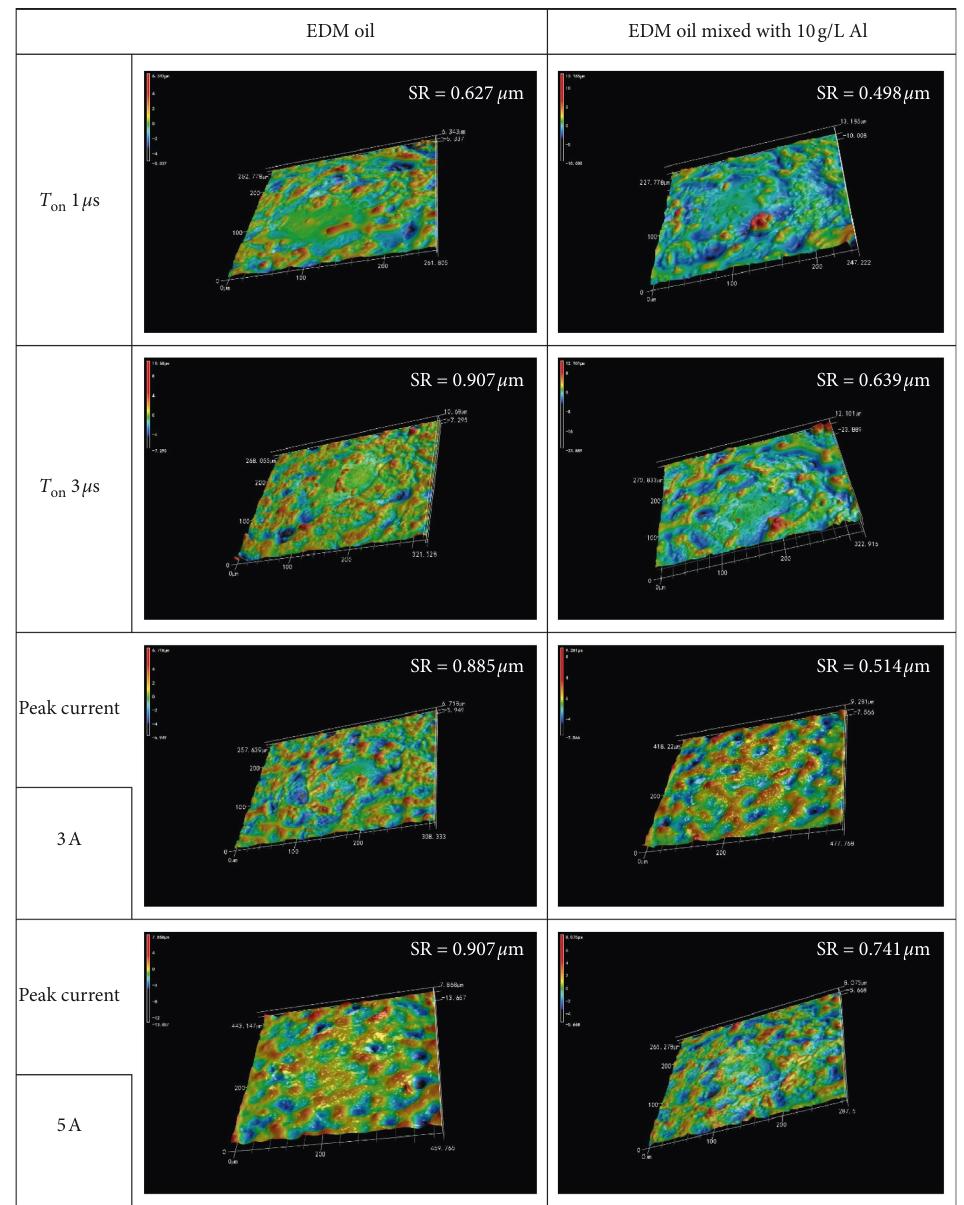
Figure 10: Surface topography plot of machined Inconel 706 between two dielectric fluids.